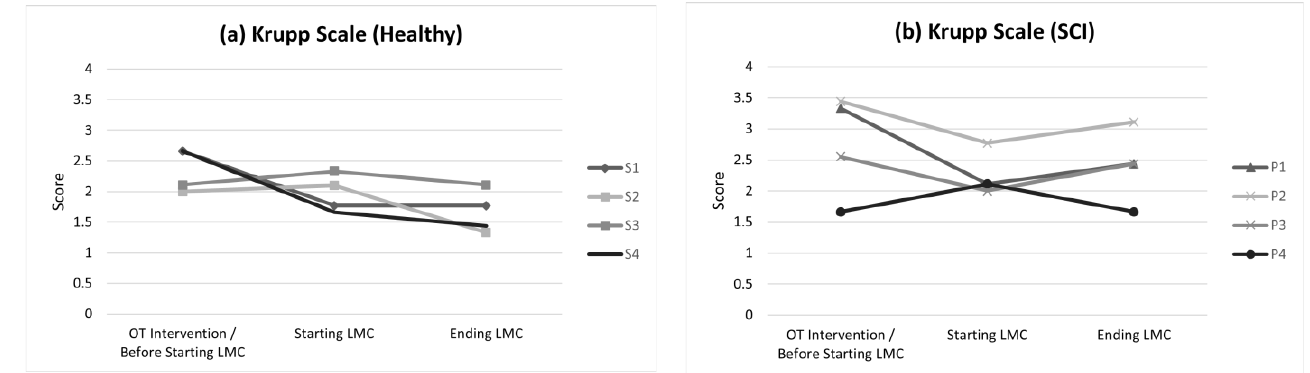
participants and ( b ) SCI Figure 4. Evolution of the participants in the results obtained on the Krupp scale: ( a ) healthy partic- ipants and ( b ) SCI patients.